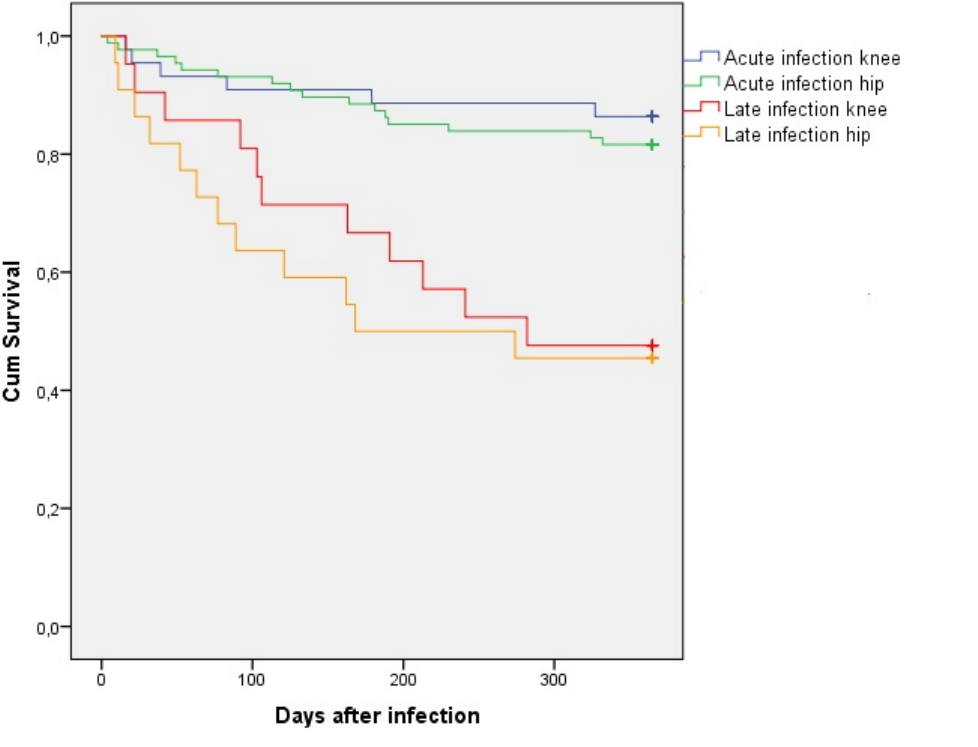
Figure 2. Prosthesis survival until 1 year after